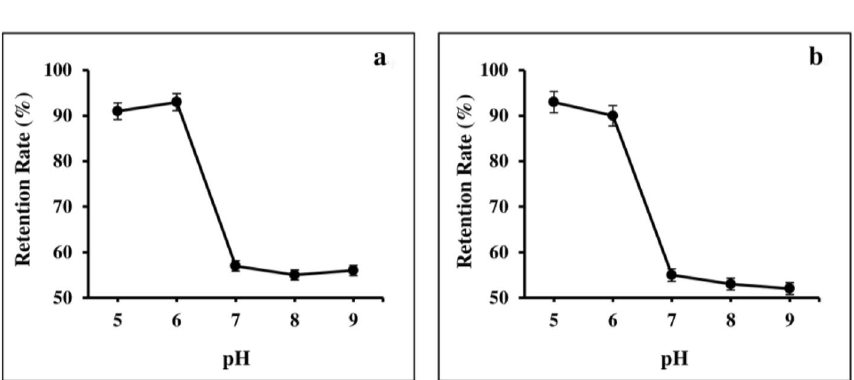
Figure 4. Retention rate percentage of Cur-NPhs at different pH; ( a ) during 24 h and ( b ) 48 h storage